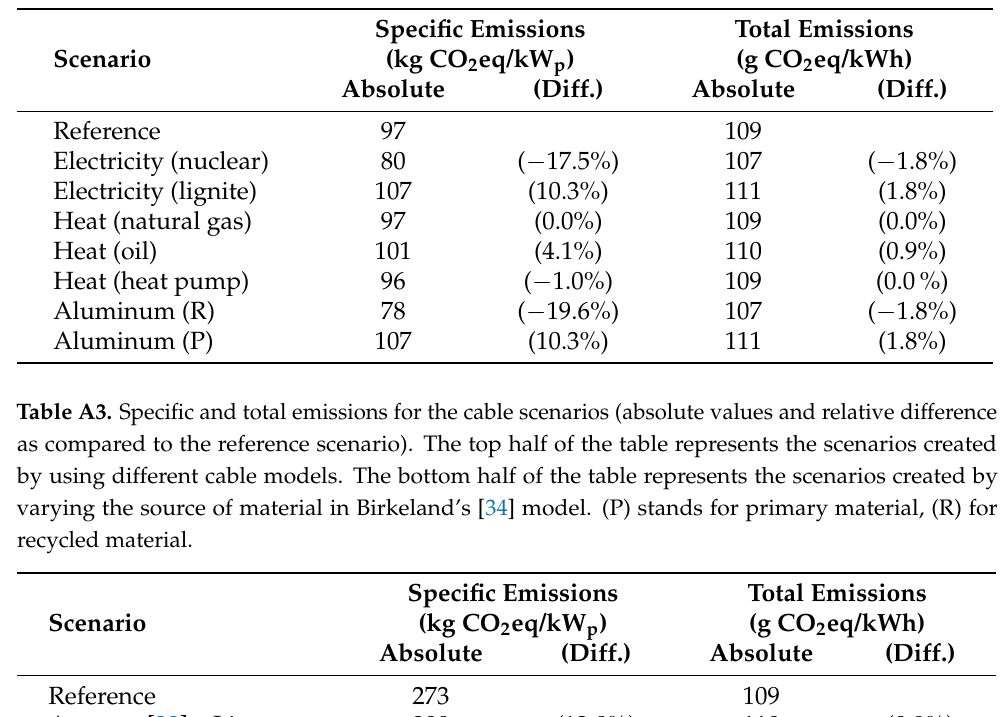
Table A2. Specific and total emissions for the battery storage system scenarios (absolute values and relative difference as compared to the reference scenario). (P) stands for primary material, (R) for recycled material.